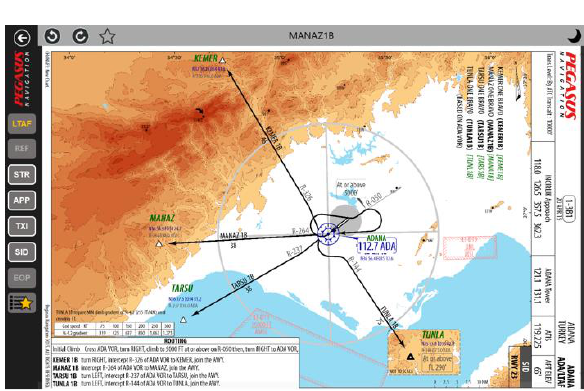
Figure 9. A screenshot inside the mobile